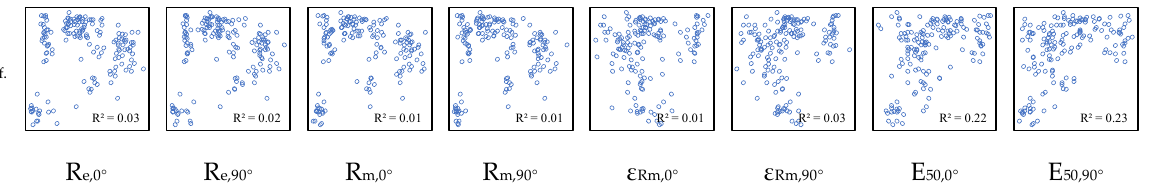
Figure 3. Fracture strain in HET as a function of the results obtained from the tensile test, defined in Table 1.